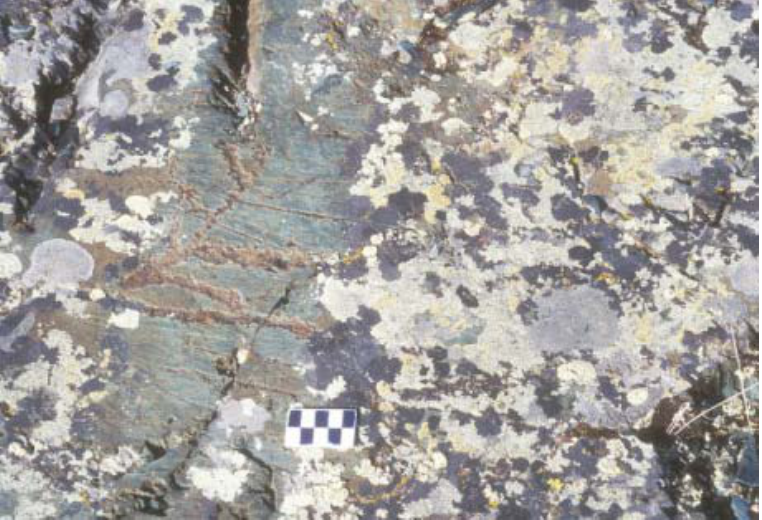
Figure 21. Contoured elk image and an identified element. Pre-Bronze Age. Aral Tolgoi.